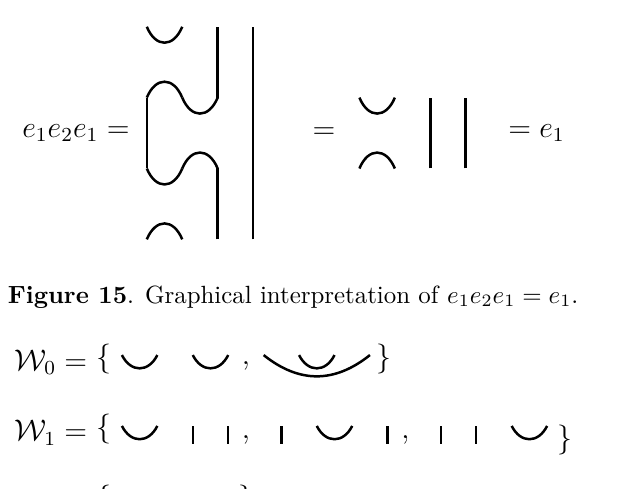
Figure 14 . Graphical interpretation of the relation e 2